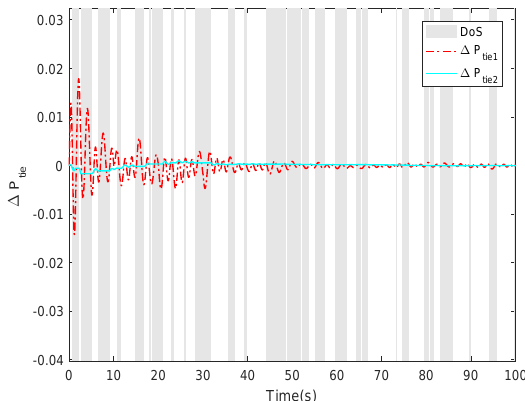
Figure 4. Tie-line power exchanges of two area power system.